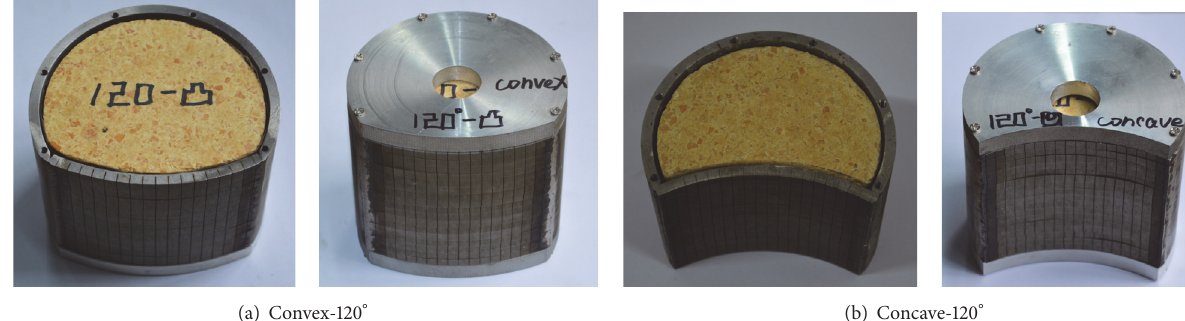
Figure 1: Specimens of concave-120 ∘ and convex-120 ∘ structures.